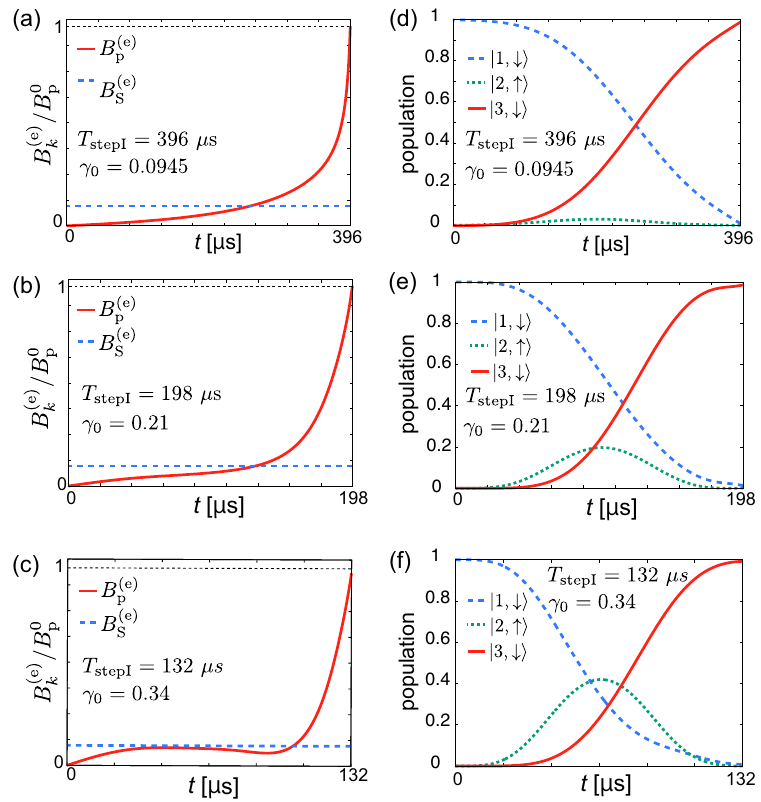
( e ) Figure 6. Envelope functions B for k = p,S normalized by B 0 p for the invariant-based engineering k protocol with ( a ) T stepI = 396 µ s, γ 0 = 0.0945 and ε = 0.02; ( b ) T stepI = 198 µ s, γ 0 = 0.21 and ε = 0.02; and ( c ) T stepI = 132 µ s, γ 0 = 0.34 and ε = 0.02. B 0 p is the maximum amplitude of the pump field. The thin dotted line represents 1. ( d )–( f ) Time dependencies of the populations corresponding to the envelope functions in the left